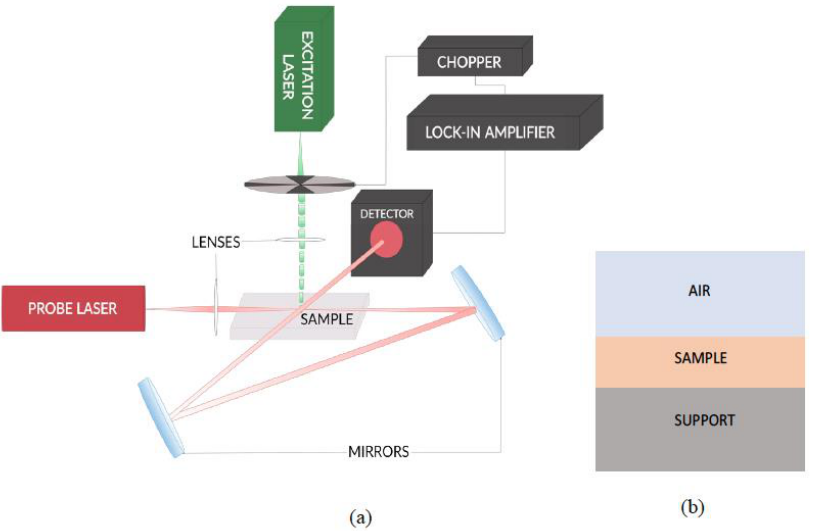
Figure 2. Scheme of the BDS experimental setup used in this work ( a ) and the arrangement of the sample position with respect to the support and the fluid (air) ( b ).